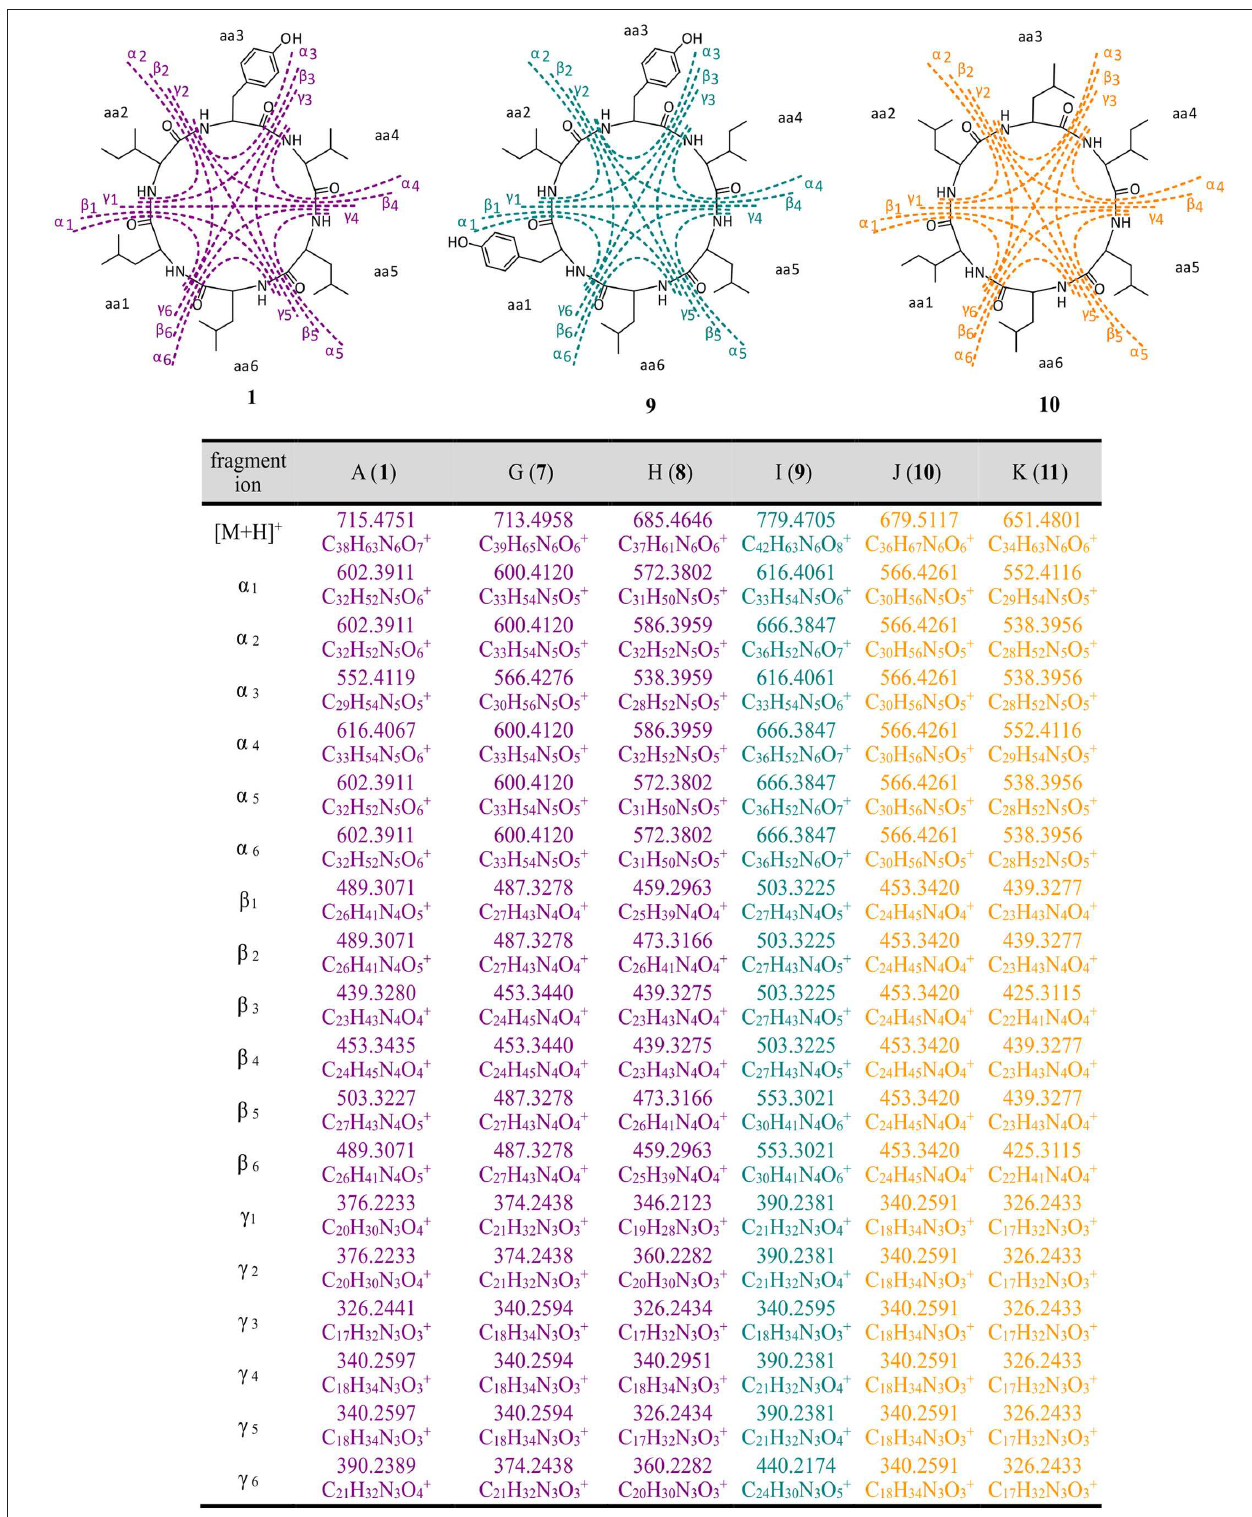
FIGURE 3 | High-resolution MS/MS fragmentations of new thermoactinoamide variants. Thermoactinoamides A ( 1 ), G ( 7 ), H ( 8 ) containing one aromatic residue are labeled in purple, while thermoactinoamides containing two ( 9 ) and no aromatic residue ( 10 and 11 ) are marked in blue and orange, respectively. Fragmentation scheme is depicted for thermoactinoamides A ( 1 ), I ( 9 ), and J ( 10 ), as representative of each class of compounds. Fragment α , β , and γ are the losses of one, two, and three amino acids from the parent ions.